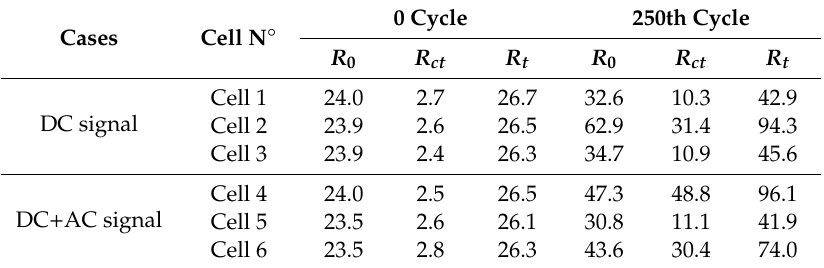
Table 3. The EIS results summary (Values in m Ω ) shows Ohmic resistance R 0 , charge-transfer resistance R ct and total resistance R t ( ≡ R 0 + R ct ) at 80% SOC. Cells 3–5 failed after 250 cycles, during the final HPPT test, therefore they were not used for the last EIS test.